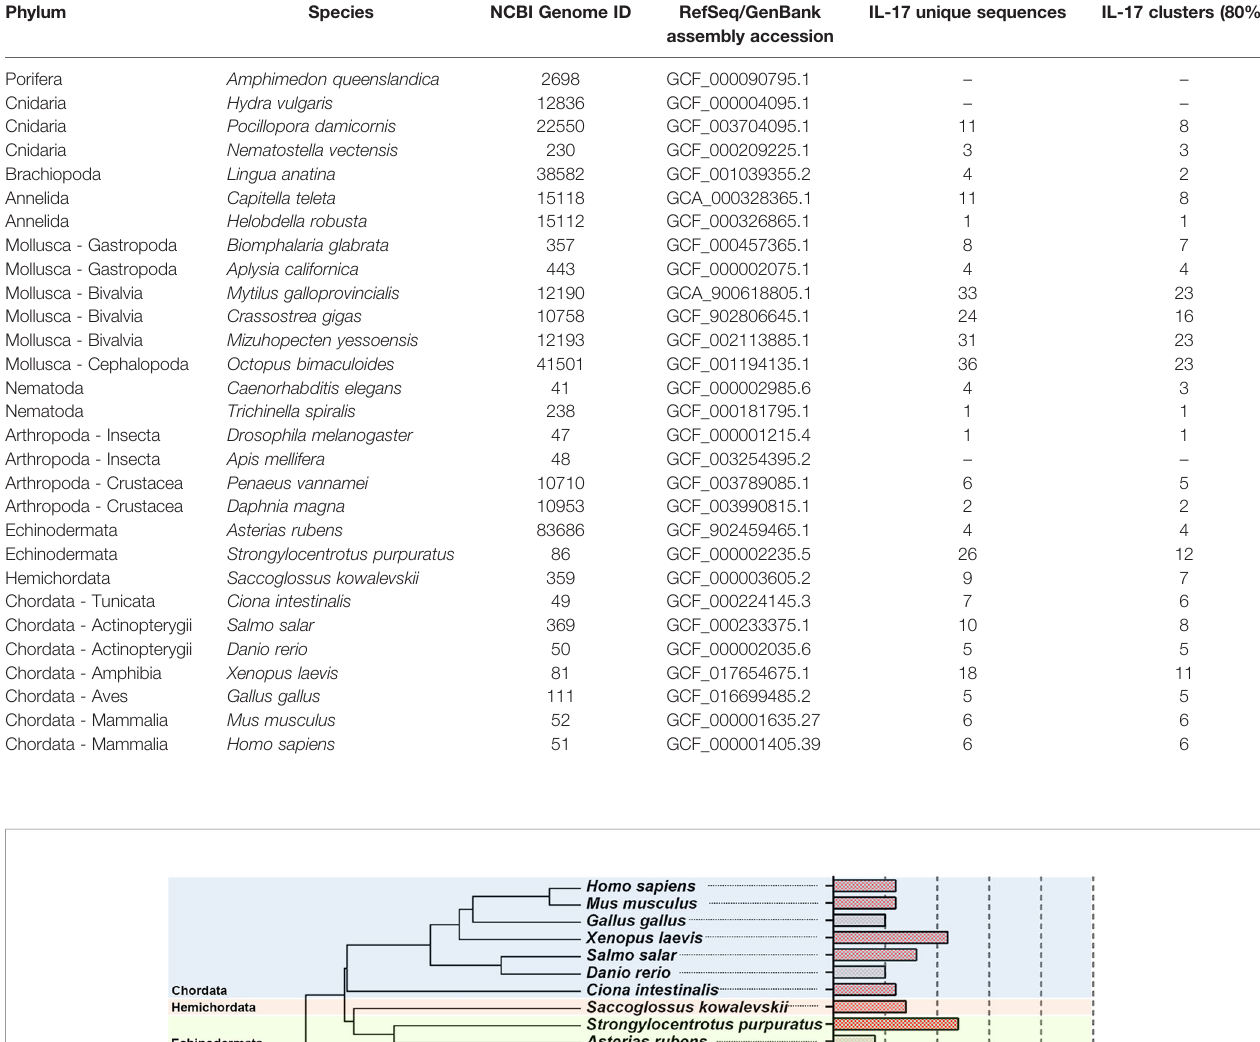
TABLE 5 | IL-17 genes and isoforms found in the analyzed species from different phyla.